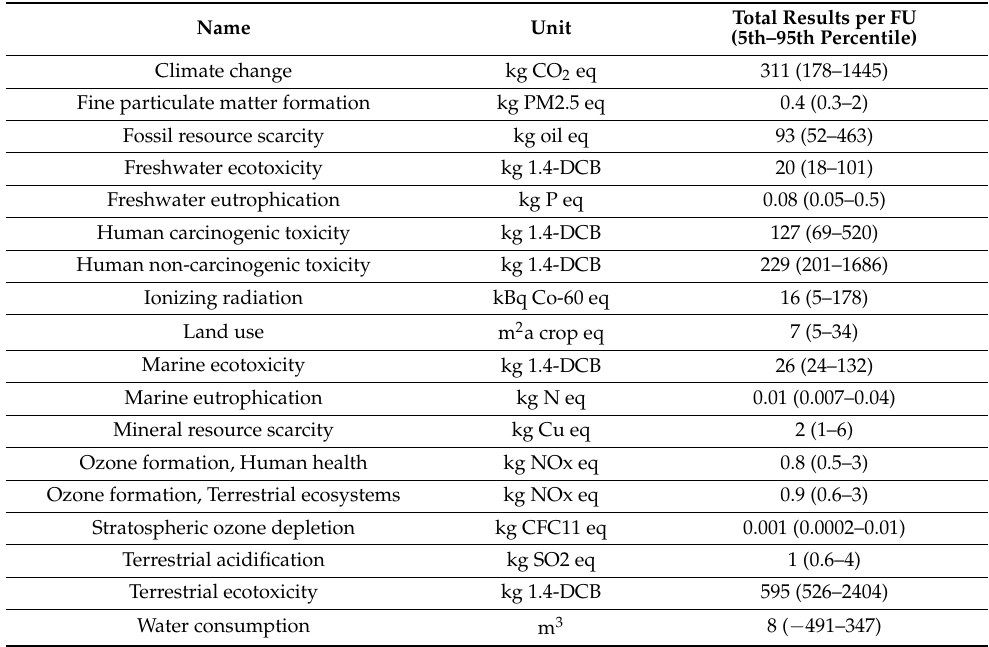
Table 5. Midpoint results to the 18 midpoint impact categories. The uncertainty ranges for the 5th and 95th percentile are shown in